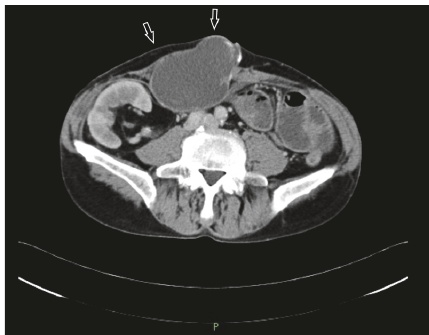
Figure 2: Abdominal CT at 4 weeks after dialysis initiation showed a marked decrease in the volume of ascitic fluid, with no change in the abdominal wall mass (arrows).